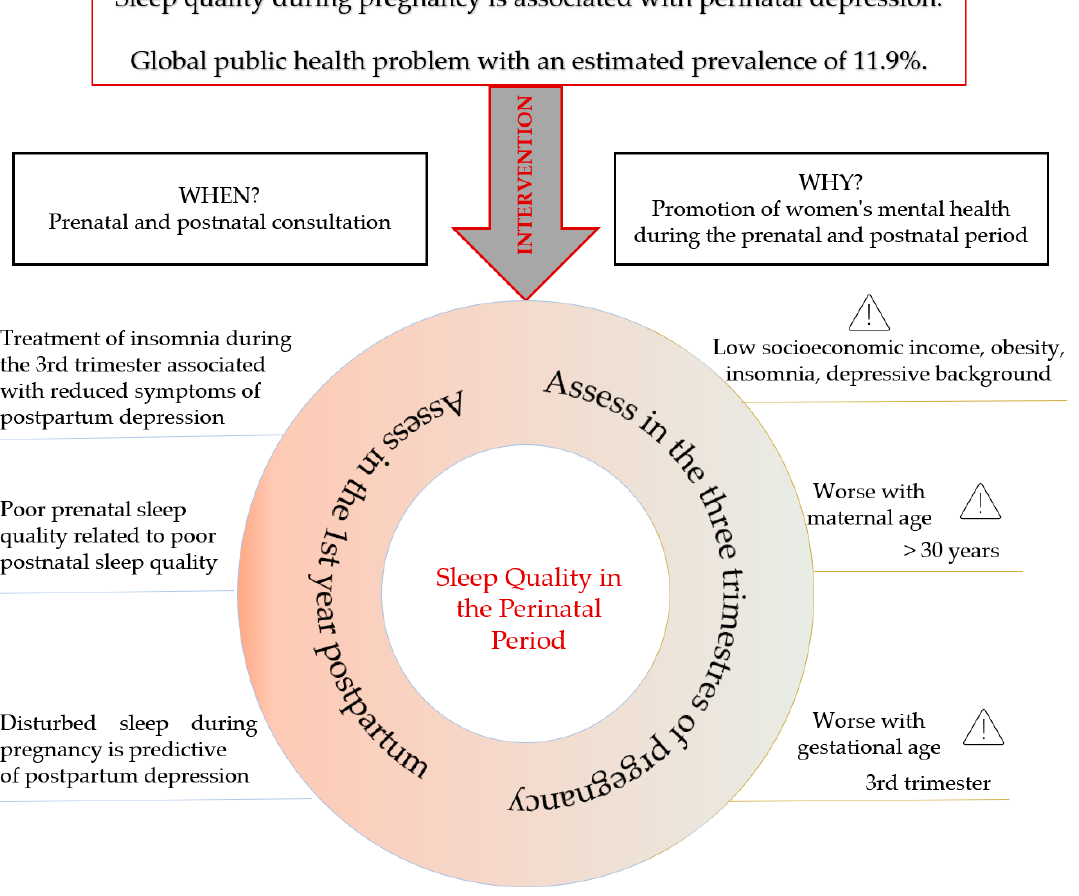
Figure 3. Construct of the synthesis of evidence on the association between sleep quality and perinatal depression.